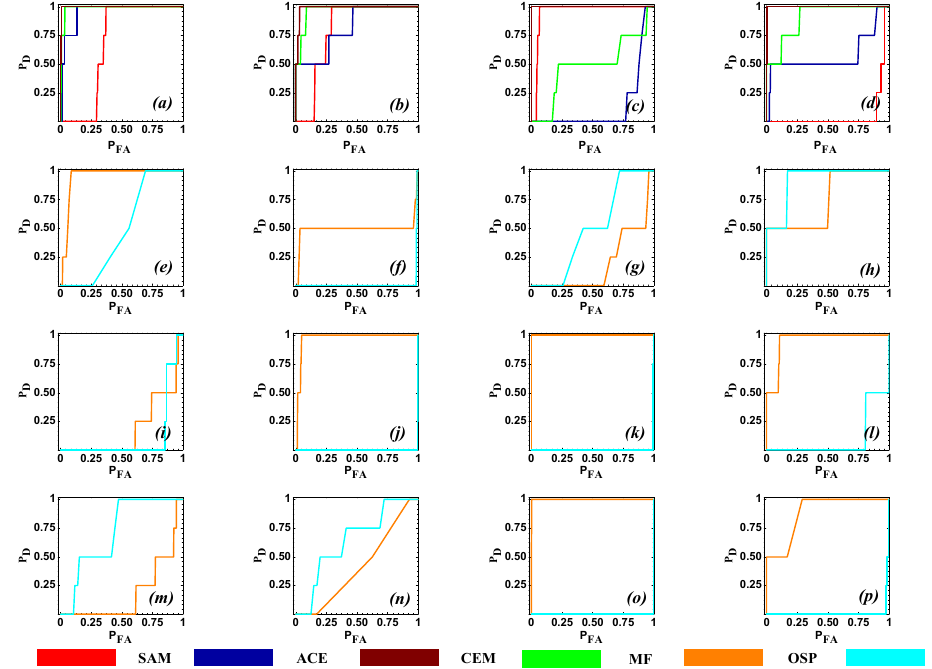
Figure 11. Target detection performance comparison in space-borne imagery for the THI target reference spectra. ROC curves for the detection from SAM, ACE, CEM, and MF for the ( a ) N1G, ( b ) N2R, ( c ) N3Y, and ( d ) N4B targets. ROC curves for the subspace-based detector OSP and TCIMF for the N1G, N2R, N3Y, C1W, and N4B targets for ( e – h ) 5, ( i – l ) 10, and ( m – p ) 15 endmember/background materials.